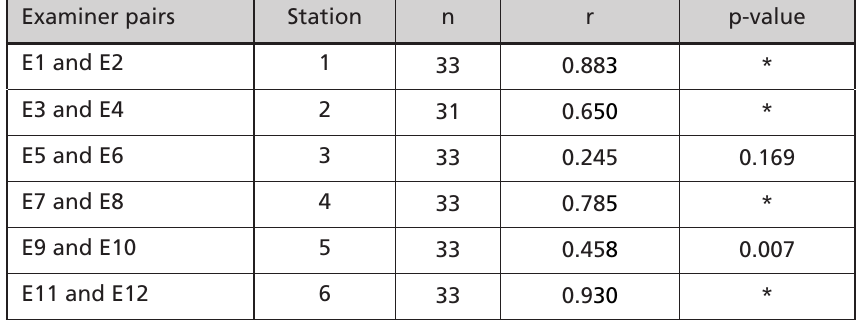
Table 3: Correlations for marks allocated by examiner pairs at each